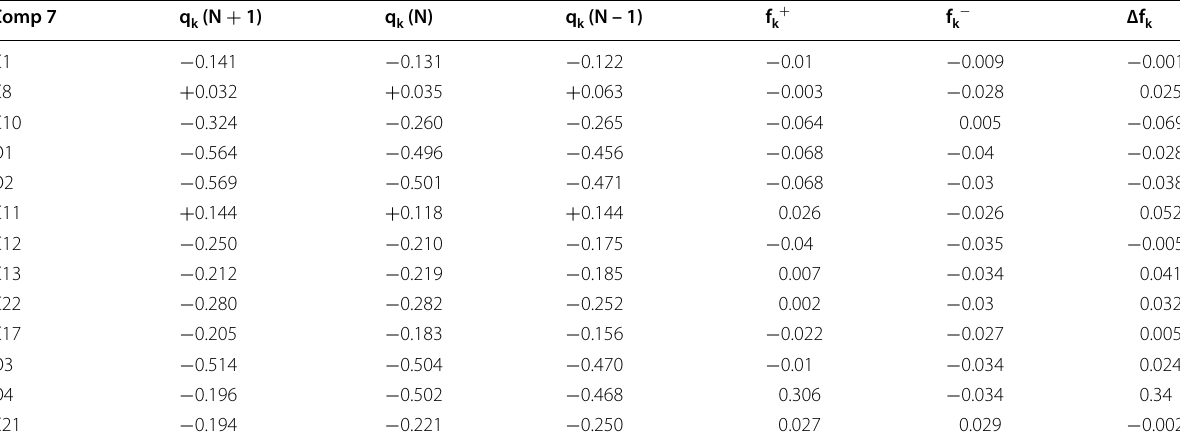
Table 8 Selected Mulliken atomic charges and Fukui functions for Compound 7